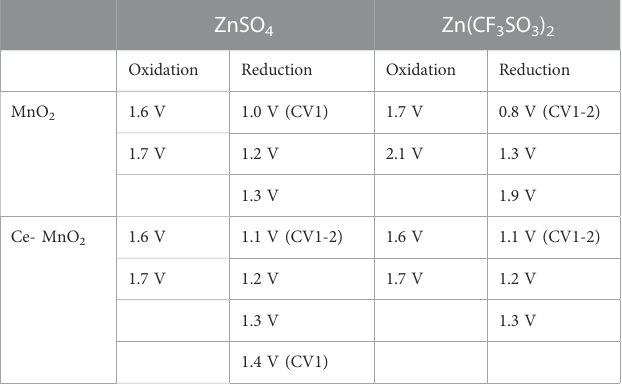
TABLE1Summaryofthepeak positionsidenti fi edfromcyclicvoltammogramsof MnO 2 and Ce-MnO 2 half-cells against Zn/Zn 2+ in ZnSO 4 and Zn(CF 3 SO 3 ) 2